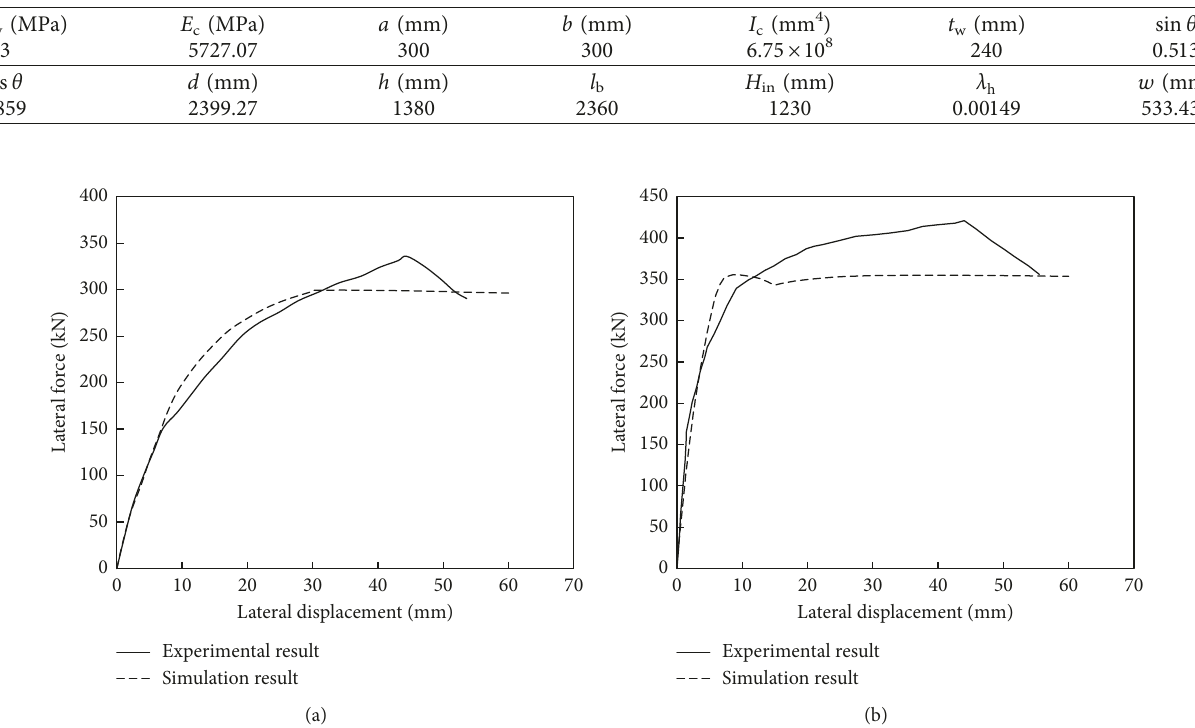
Figure 16: Steel bar stress versus slip for completely anchored reinforcing bars into footings. Table 4: Parameters of equivalent diagonal strut model for